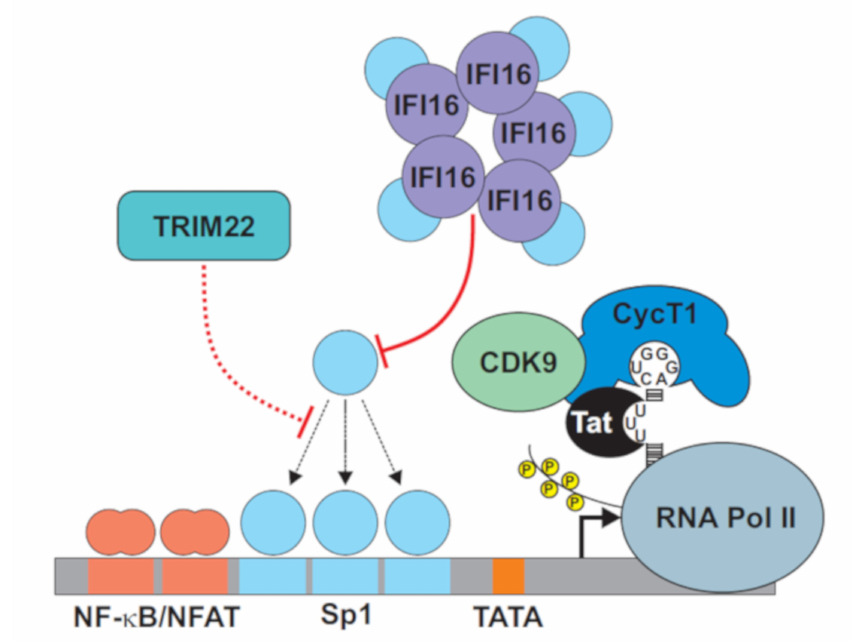
Figure 1. Specificity protein 1 (Sp1) targeting suppresses HIV-1 transcription. As outlined in the text, the viral transactivator of transcription protein (Tat) interacts with the TAR region at the 5’ end of the viral RNA and recruits several cofactors for e ff ective viral transcription. The latter is also dependent on the availability of the cellular transcription factors nuclear factor kappa B (NF- κ B) and Sp1. Cellular factors tripartite motif-containing protein 22 (TRIM22) and γ -IFN-inducible protein 16 (IFI16) target Sp1 to suppress HIV-1 transcription and reactivation from